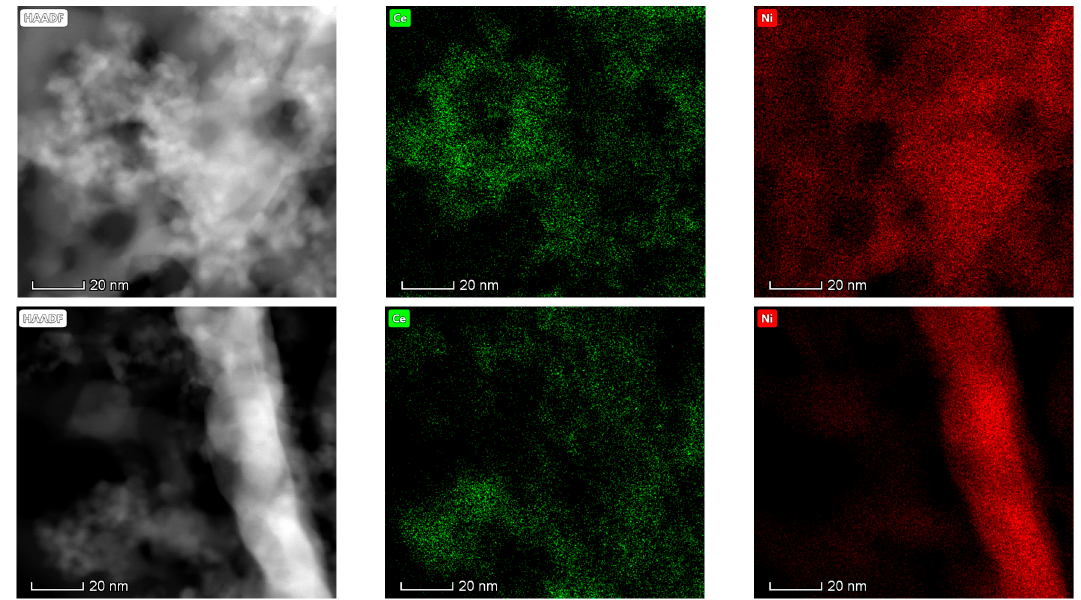
Figure 6. High-angle annular dark-field scanning–transmission electron microscopy (HAADF-STEM) images of Ni-Ce-8 and energy-dispersive X-ray spectroscopy (EDS) chemical maps of Ni and Ce.